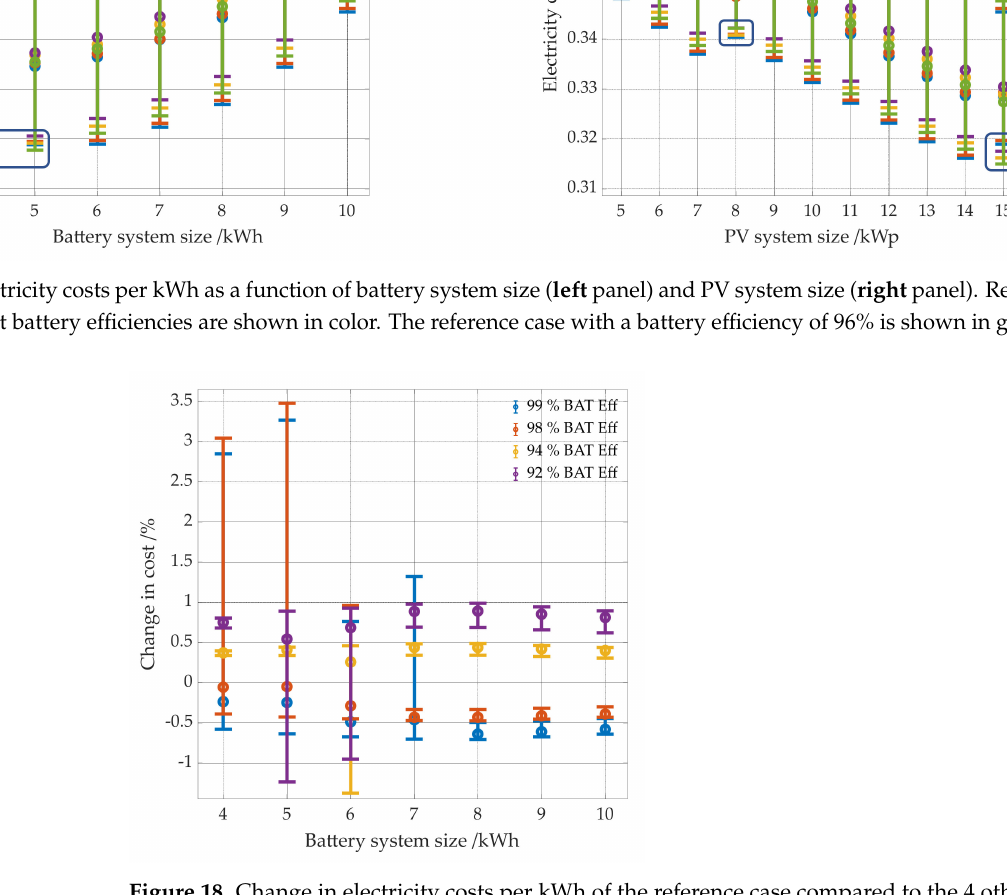
Figure 18. Change in electricity costs per kWh of the reference case compared to the 4 other simula- tions, with a battery efficiency of 92, 94, 98, 99% as a function of the battery system